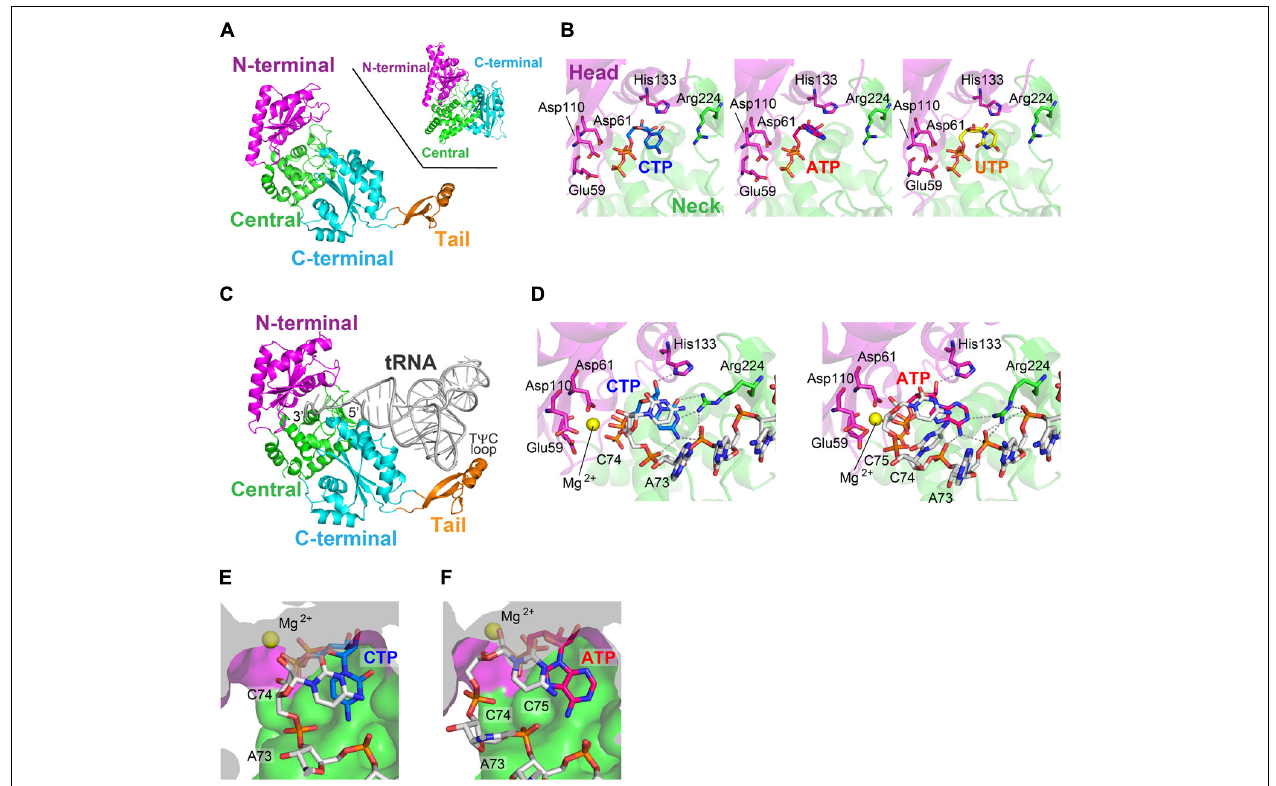
and UTP (right). Nucleotides are depicted by stick models. (C) Complex structure of AFCCA with tRNA. ( D) Catalytic core structure at the C 75 -adding stage (left) and the A 76 -adding stage (right). (E) Nucleotide binding pocket at the C 75 -adding stage. (F) Nucleotide binding pocket at the A 76 -adding stage. The pocket structures in (E) and (F) are depicted by surface models.